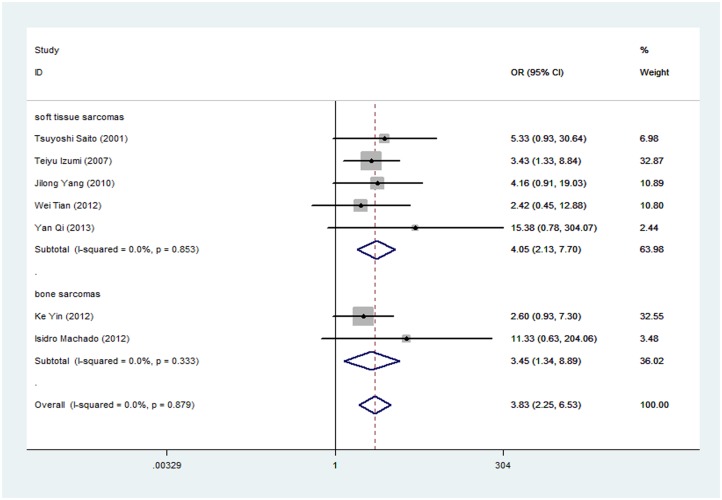
Forest plot (fixed effects model) about the association between E-cadherin expression with overall survival in patients with soft tissue sarcomas and bone sarcomas respectively.(P = 0.000, OR = 4.047; 95%CI: 2.127–7.700) (P = 0.01, OR = 3.447; 95%CI: 1.336–8.893). (fixed-effects model analysis).